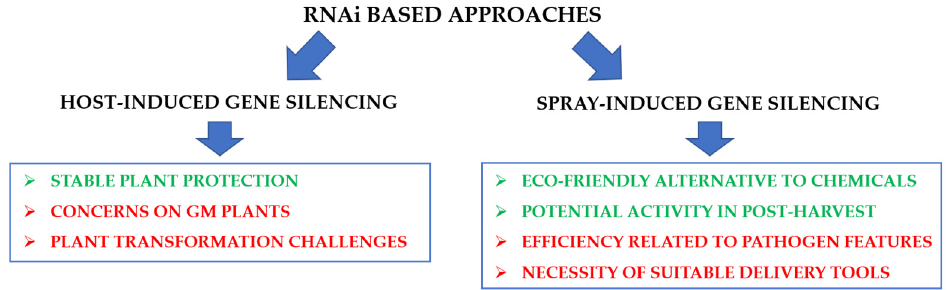
Figure 3. RNAi-based approaches for plant protection: host-induced gene silencing, HIGS ( left panel) and spray-induced gene silencing, SIGS ( right panel). The main advantages (in green) and disadvantages (in red) related to each strategy are reported. See text for further information.